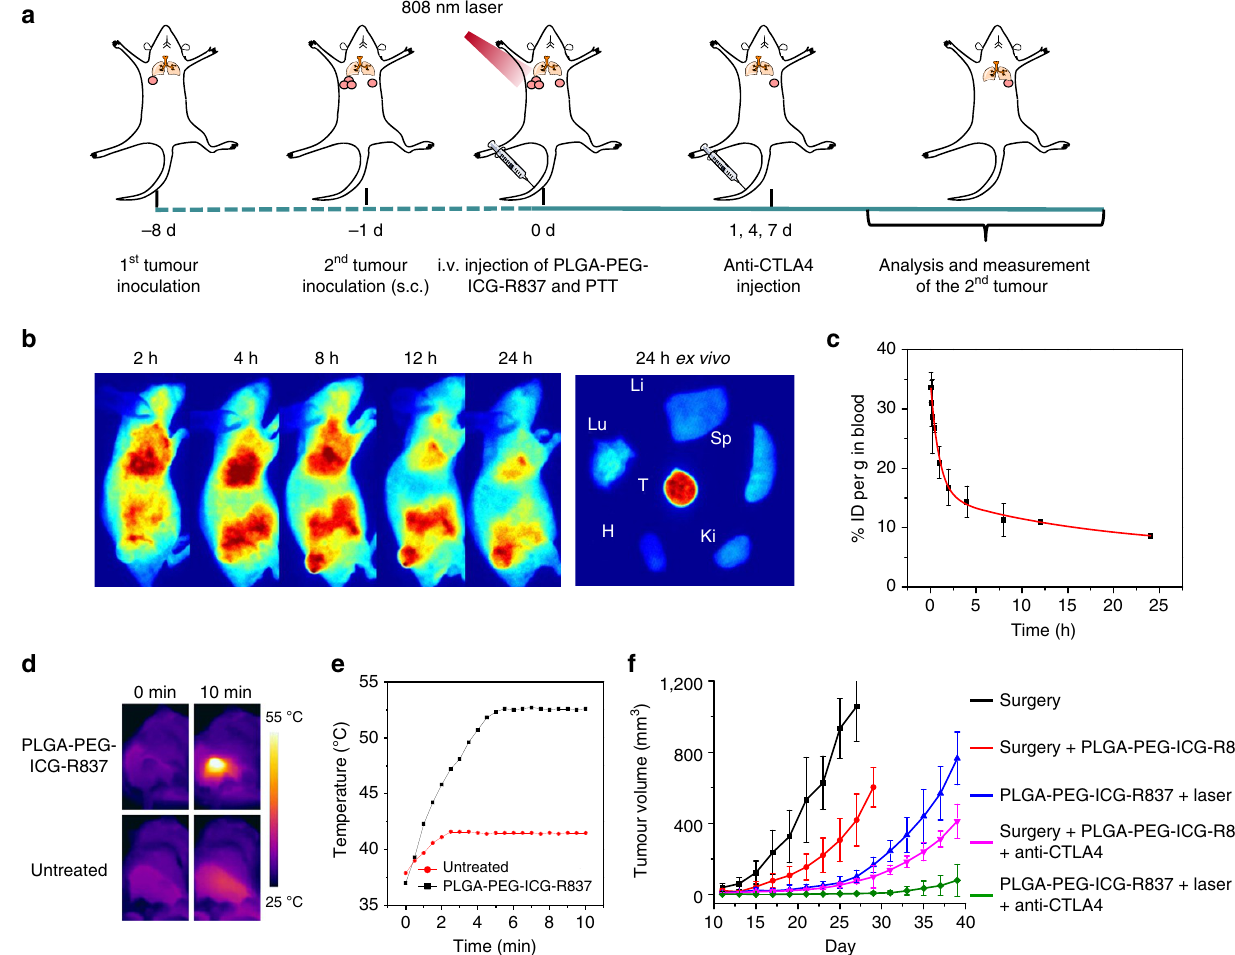
Figure 6 | PTT-triggered immunotherapy via systemic injection of nanoparticles. ( a ) Schematic illustration showing the design of animal experiments. ( b ) In vivo fluorescence images of CT26-tumour-bearing mice taken at different time points post i.v. injection of PLGA-PEG-ICG-R837. The right column shows an ex vivo fluorescence image of major organs and tumour dissected from the mouse 24h post injection. Tu, Li, Sp, Ki, H and Lu stand for tumour, liver, spleen, kidney, heart and lung, respectively. ( c ) Blood circulation curve of PLGA-PEG-ICG-R837 in mice by measuring the fluorescence of ICG in blood at different time points post i.v. injection (three mice per group). ( d ) IR thermal images of CT26-tumour-bearing mice injected with PLGA-PEG-ICG-R837 or PBS under the 808nm laser (0.8Wcm (cid:2) 2 ) irradiation. ( e ) The tumour temperature changes based on IR thermal imaging date in d . ( f ) The growth curves of secondary tumours in different groups of CT26-tumour-bearing mice after various treatments to eliminate their primary tumours (six mice per group). Data are presented as the mean ±